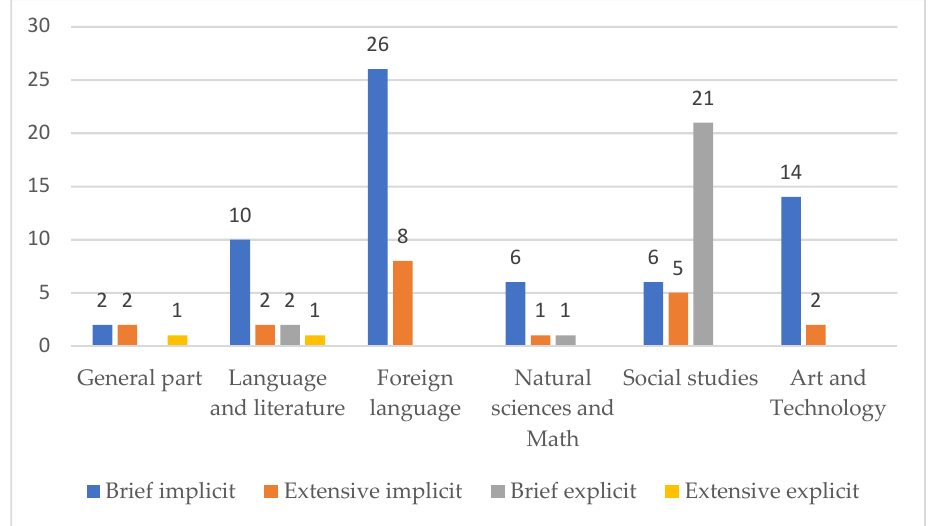
Figure 1. General provisions of NCBS and subject field descriptions for basic schools according to the categories (Levander and Mikkola 2009).